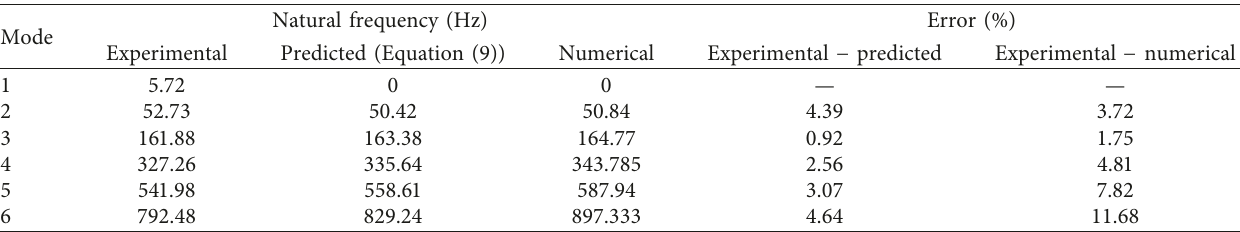
Table 4: Natural frequencies of the pinned-free beam with respect to the weak axis ( Y ).